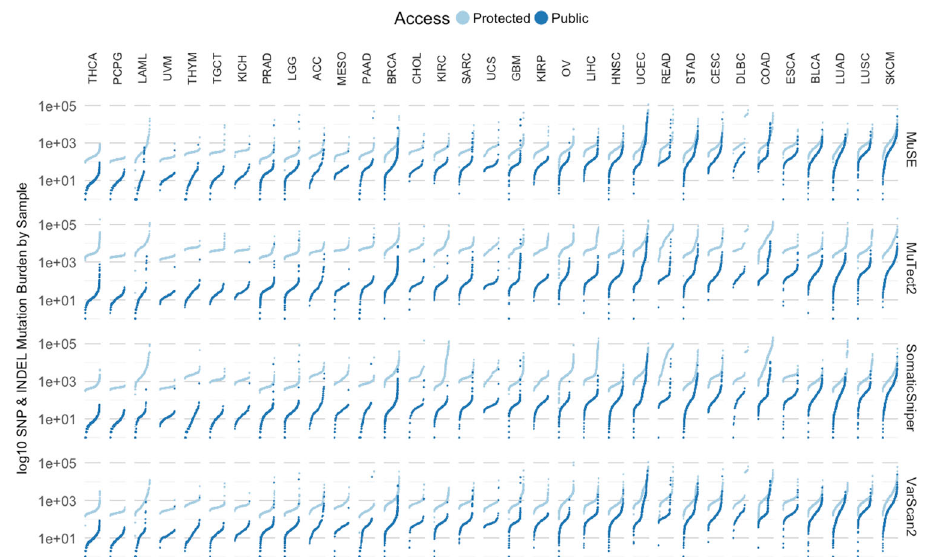
Fig. 1 Mutation loads of TCGA projects. GDC-detected somatic variants per sample are displayed by each pipeline (rows), and grouped in each project (columns). Combined counts of point mutations (SNP) and INDELs of either public MAF (dark blue) or protected MAF (light blue) are plotted in separate colors.